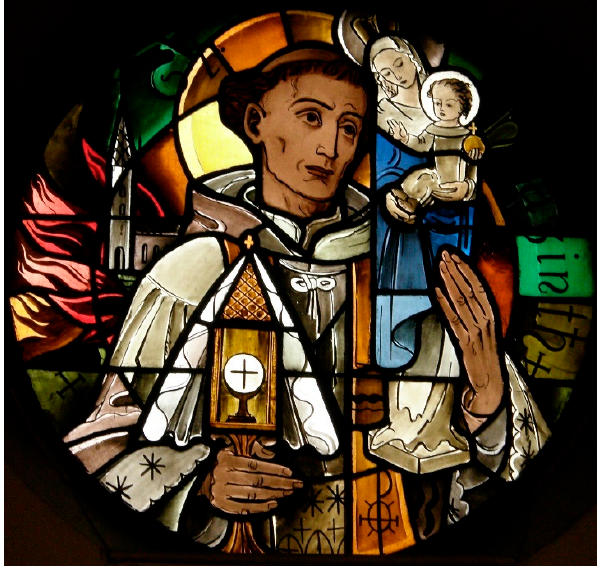
Figure 9. Saint Hyacinth, stained-glass window in the Christ the King Church in Gliwice (Ger. Gleiwitz), 1937. Created by